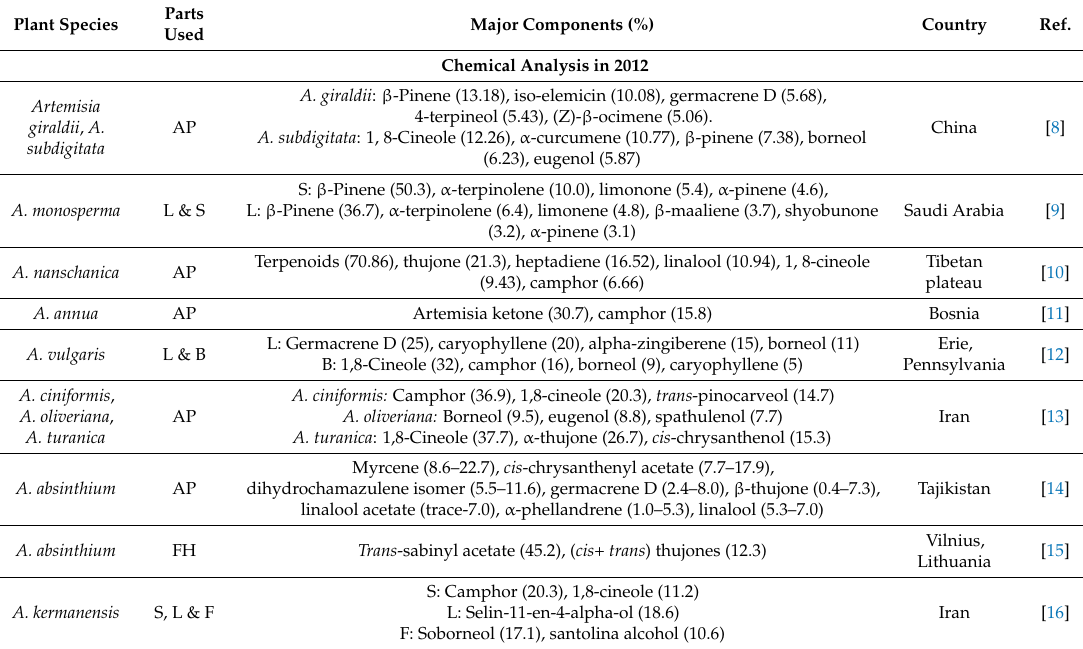
Table 1. A literature report from 2012–2017 on chemical composition of Artemisia oils from different geographical regions (Plant part: AP: aerial parts; F: flowers; FH: flower-heads; L: leaves; B: